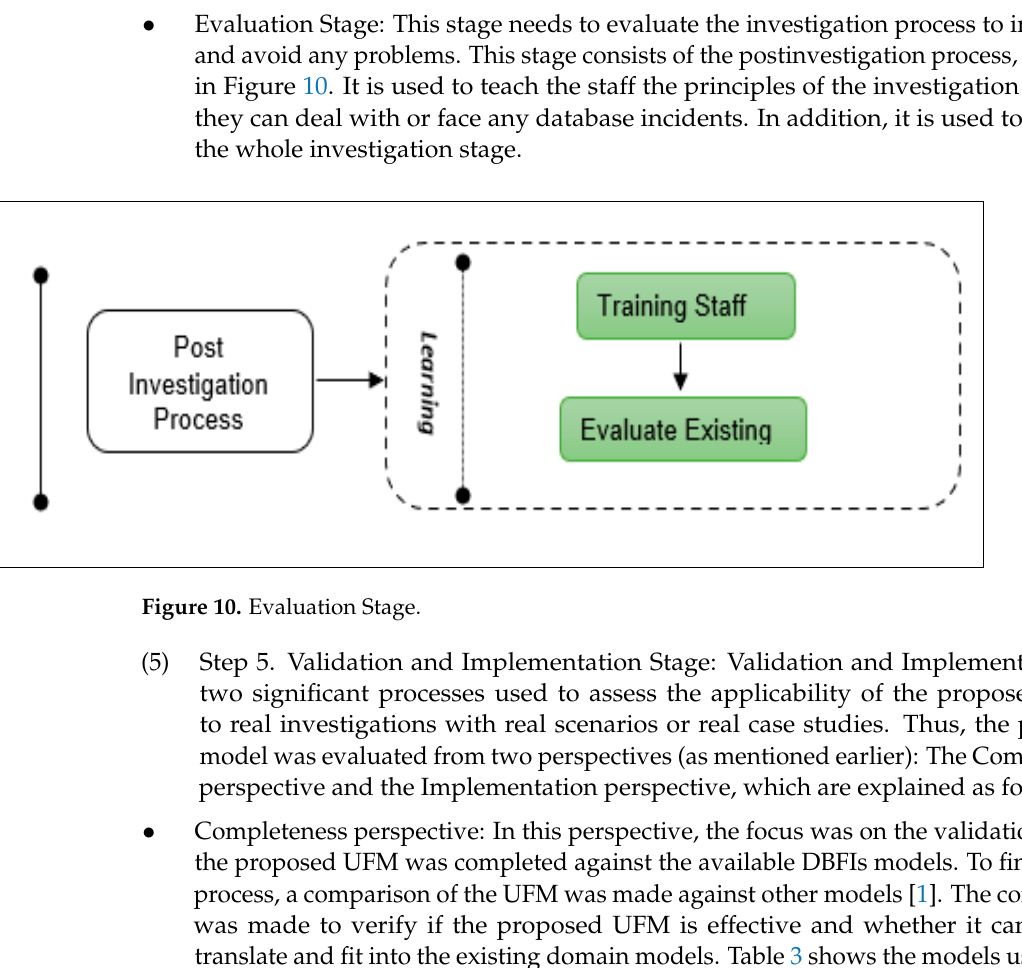
Figure 9. Restoring and recovering stage.